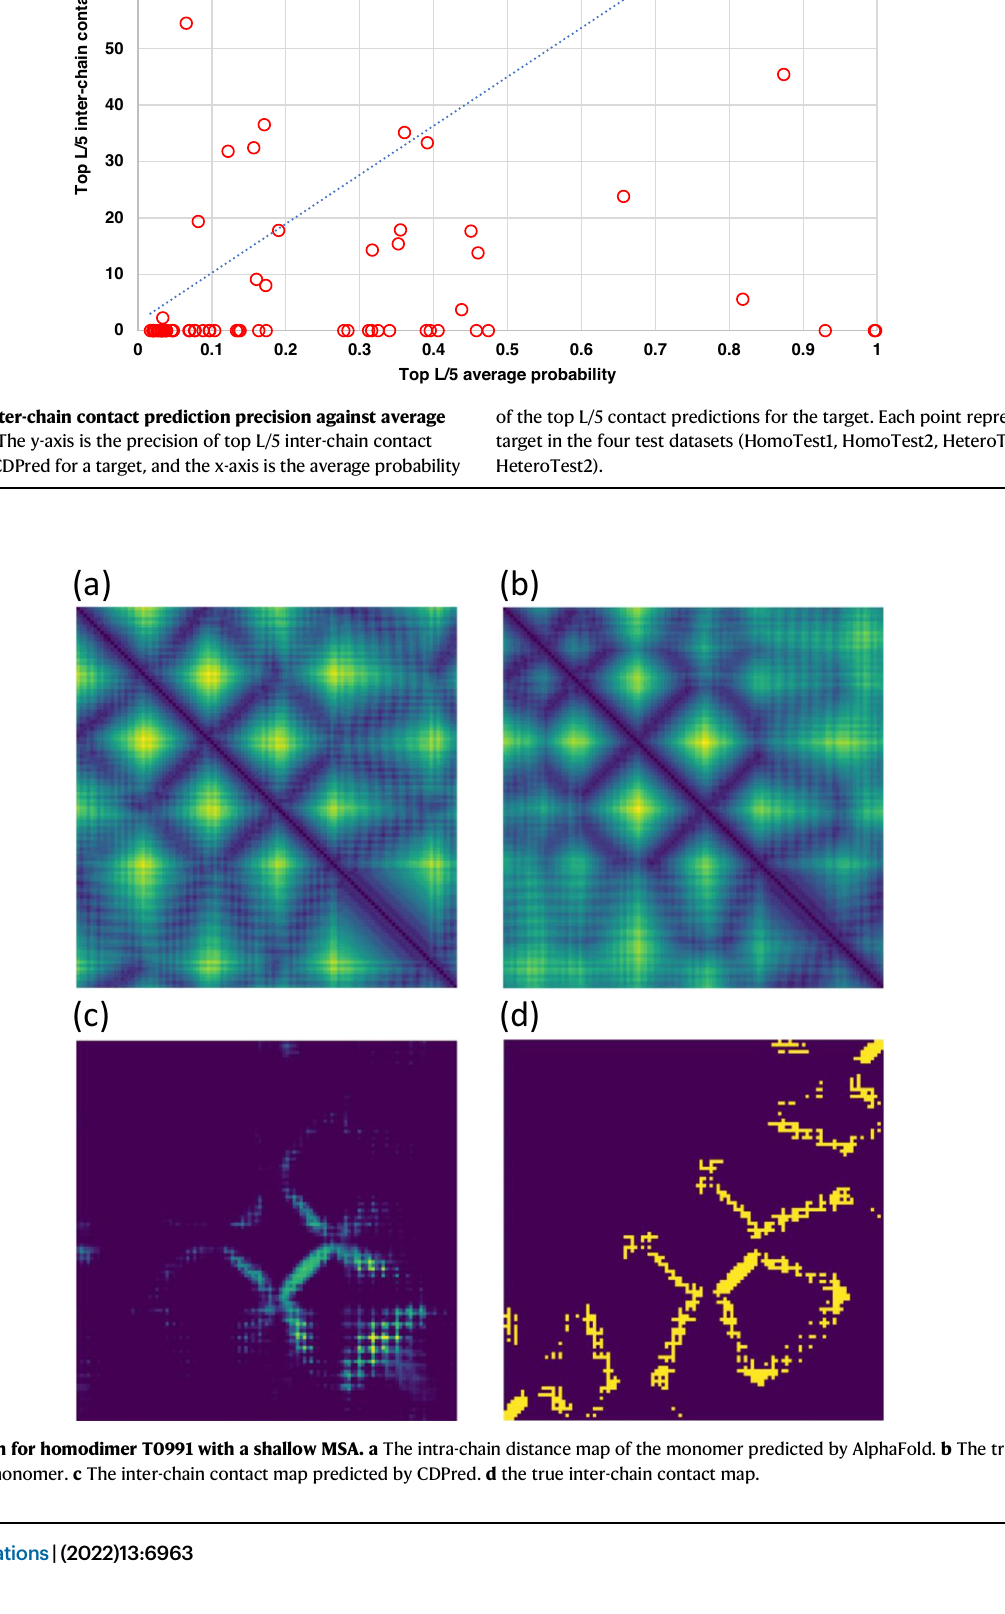
Fig. 5 | The prediction for homodimer T0991 with a shallow MSA. a The intra-chain distance map of the monomer predicted by AlphaFold. b The true intra-chain distance map of the monomer. c The inter-chain contact map predicted by CDPred. d the true inter-chain contact